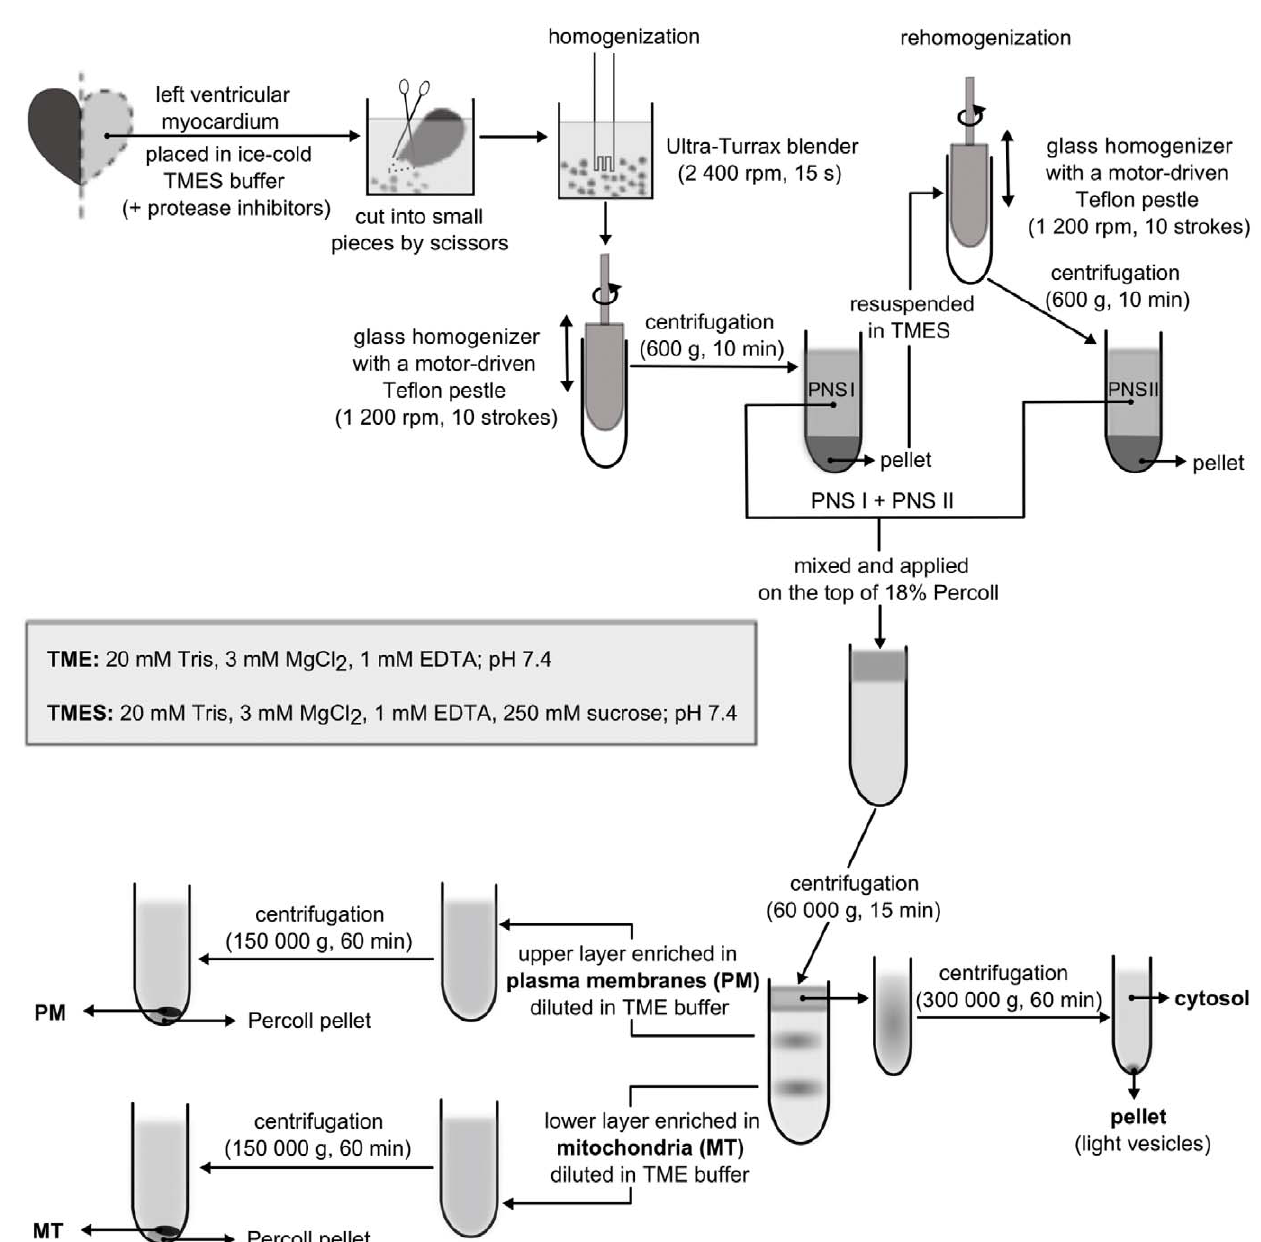
Figure 1. Flow diagram of the fractionation procedure for the rat myocardium. The left ventricles were cut into small pieces with dissecting scissors, homogenized using an Ultra-Turrax homogenizer and subsequently with a motorized glass-Teflon homogenizer. The postnuclear supernatant (PNS I) after low-speed centrifugation was collected and the pellet rehomogenized in a glass-Teflon homogenizer. The resulting postnuclear supernatant (PNS II) was collected, mixed with PNS I and applied on the top of 18% Percoll density gradient. After high-speed centrifugation, the top portion of the gradient mainly containing soluble material was further centrifuged to yield a clear cytosolic fraction. The upper layer enriched in plasma membranes (PM) and the lower layer rich in mitochondria (MT) were separately diluted in TME buffer and spun down to remove the Percoll, which formed a compact glassy pellet at the bottom of the centrifuge tube. The sedimented PM or MT containing material formed a loose white layer on the Percoll pellet and could be easily collected by pipetting. All centrifugation steps were performed at 4 u C and tubes were kept on ice during samples collection. doi:10.1371/journal.pone.0047167.g001 background subtraction. To estimate the false discovery rate (FDR) a decoy database search was performed. For each protein ratio the Protein Pilot reported p-value and EF (error factor). To be considered as differentially expressed, individual proteins had to SDS-PAGE. After electrotransfer onto nitrocellulose membranes, fulfill the following statistical criteria: P value , 0.05, EF , 1.5 and selected proteins were detected on Western blots using appropriate average iTRAQ ratio . 2. antibodies. Immunochemically reactive proteins were visualized